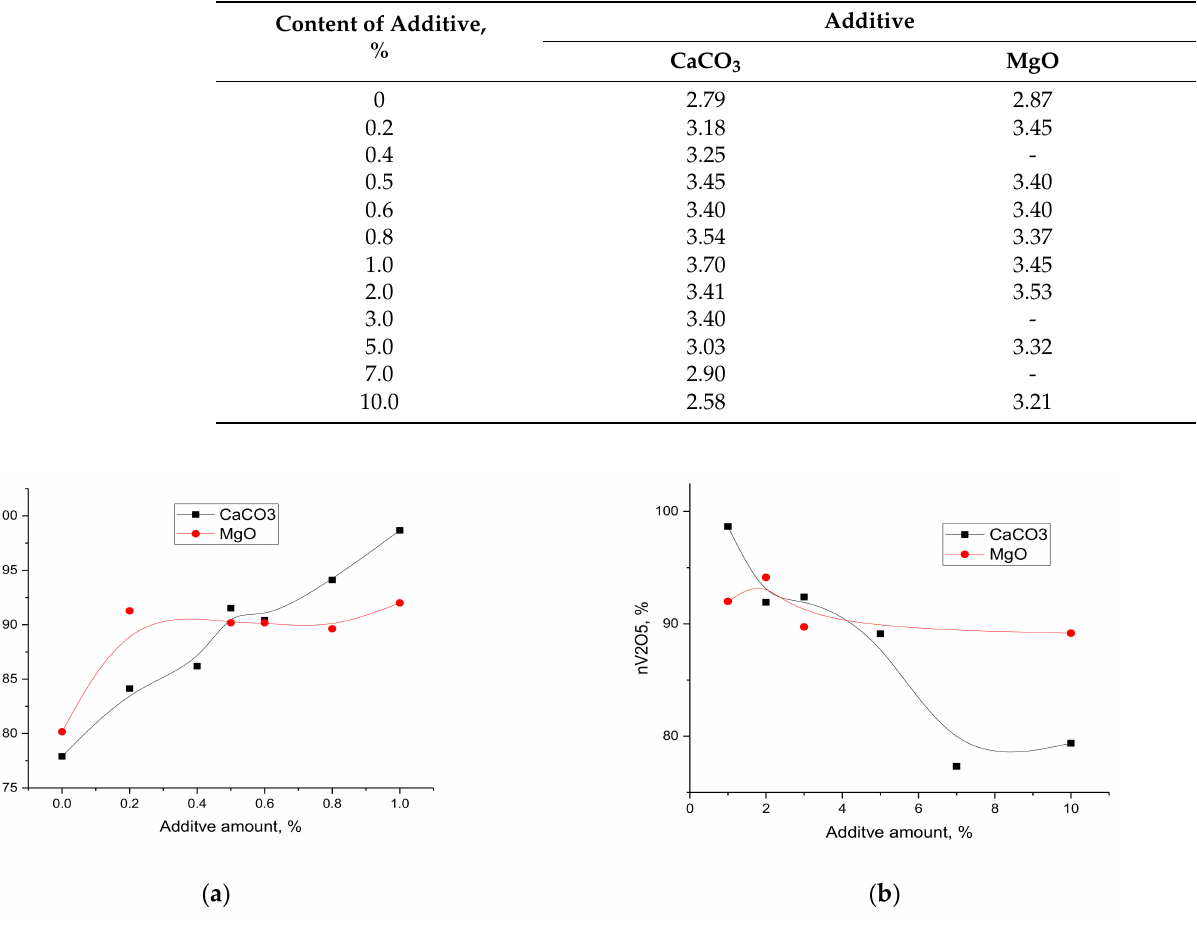
Figure 2. Effects of CaCO 3 and MgO addition on η V2O5 in roasted sludge at optimal roasting temperature (1000 ◦ C for CaCO 3 and 900 ◦ C for MgO): ( a )—addition amount of 0–1%; ( b )—addition amount of 1–10%. The experimental curves were processed by the B-spline (basis spline) method.